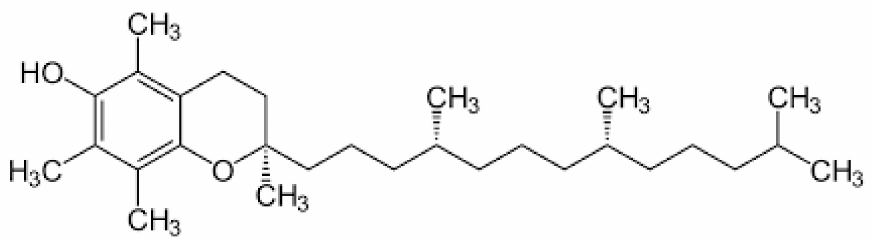
Figure 4. Molecular structure of α